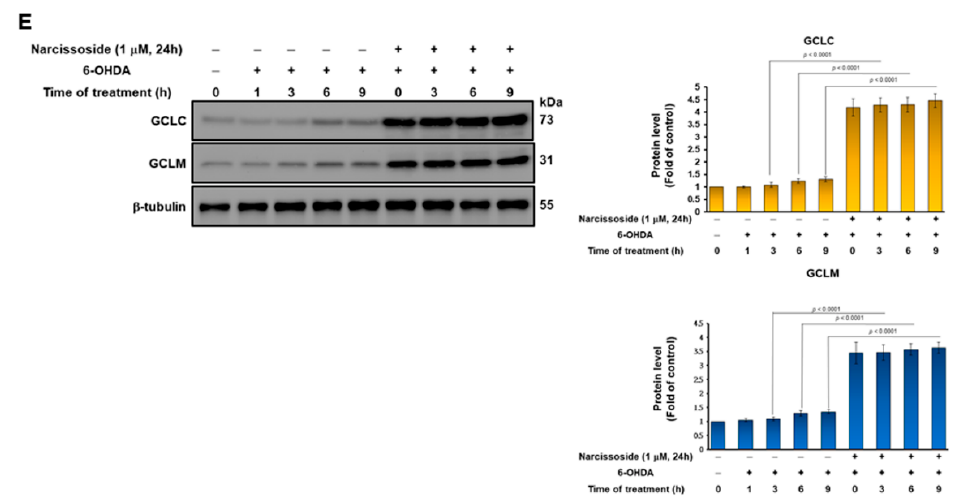
Figure 3. Glutathione (GSH) is involved in the neuroprotective effect of narcissoside (NCS), pre- venting 6-OHDA-induced reactive oxygen species (ROS) generation in SH-SY5Y cells. ( A ) Cells were pretreated with a series concentration of NCS for 24 h, then treated 100- μ M 6-OHDA for 18 h. ROS levels were measured using the H2DCFDA method. ( B ) Cells were treated with 1 μ M NCS for 0, 6, 12, or 24 h and then measure GSH level by GSH assay kit. ( C ) The protein expression of the catalytic subunit (GCLC) and modifier subunit (GCLM) of glutamate cysteine ligase ( γ -GCL) in ( B ) was determined by western blotting. The expression of β -tubulin is internal control. (leaf). The in- tensity of the signal was quantified by the ImageJ software. (right). ( D ) Cells were pretreated with or without 1- μ M NCS for 24 h, and then treated 100- μ M 6-OHDA for the indicated times. GSH levels were measured using a GSH assay kit. ( E ) The protein expression of GCLC and GCLM in ( D ) was determined by western blotting. The expression of β -tubulin is internal control. (leaf). The intensity of the signal was quantified by the ImageJ software. (right). The metabolism of intracellular ROS can be converted into less toxic molecules by antioxidants or enzymes, and glutathione (GSH) is a major member. Therefore, we wanted to assess whether NCS would regulate the amount of GSH in SH-SY5Y cells. The results indicated that treatment of 1 μ M NCS for 24 h raised the amount of GSH by 3.4- fold, compared with the control group ( p < 0.0001) (Figure 3B). Next, we considered whether the augmented amount of GSH was related to improved expression of the rate- limiting enzyme glutamate cysteine ligase (GCL) at its synthetic step. GCL consists of the catalytic subunit GCLC and the modifier subunit GCLM. The effect of NCS on the expres- sion of GCLC and GCLM was analyzed by western blotting. The results revealed that treatment of 1 μ M NCS for 24 h increased the amount of GCLC and GCLM 4.3-fold ( p < 0.0001) and 3.6-fold ( p = 0.0001), respectively, compared to the control group (Figure 3C). Whereas, for cells treated to 100- μ M 6-OHDA for 9 h, pretreatment with 1- μ M NCS for 24 h significantly increased the level of intracellular GSH by 2.8-fold ( p < 0.0001), compared with the unpretreated group (Figure 3D). The influence of NCS on GCLC and GCLM ex- pression in cells exposed to 6-OHDA for 9 h was analyzed by western blotting. The results showed that pretreatment of 1- μ M NCS for 24 h increased the expression of GCLC and GCLM by 3.5-fold ( p < 0.0001) and 2.8-fold (p < 0.0001), respectively, compared with the unpretreated group (Figure 3E).